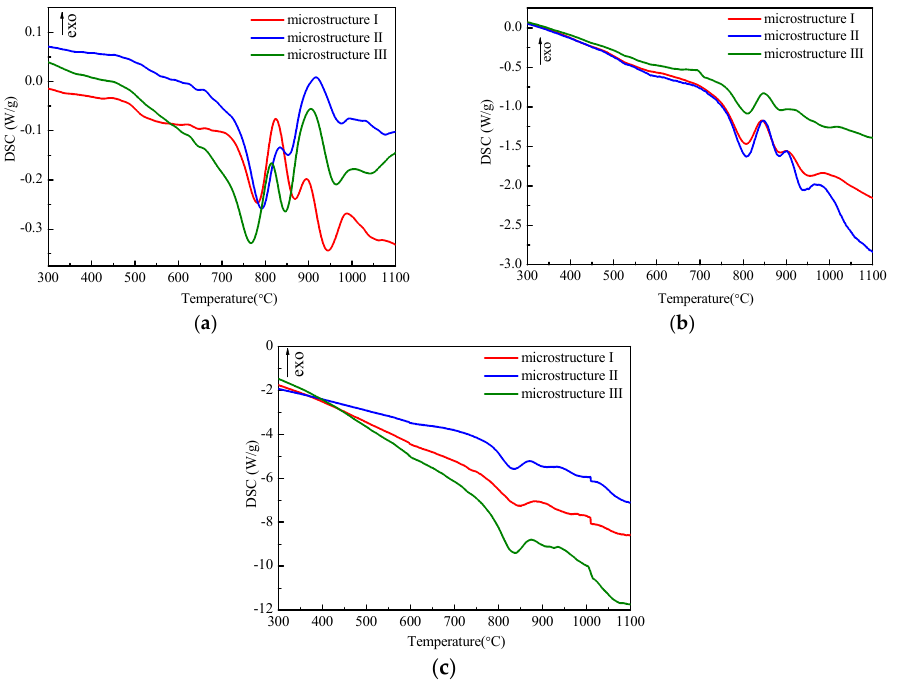
Figure 7. DSC curves of the different initially structures at the heating rate of ( a ) 10 °C/min; ( b ) 20 °C/min; ( c ) 40 °C/min. ( b ) 20 ◦ C/min; ( c ) 40 ◦